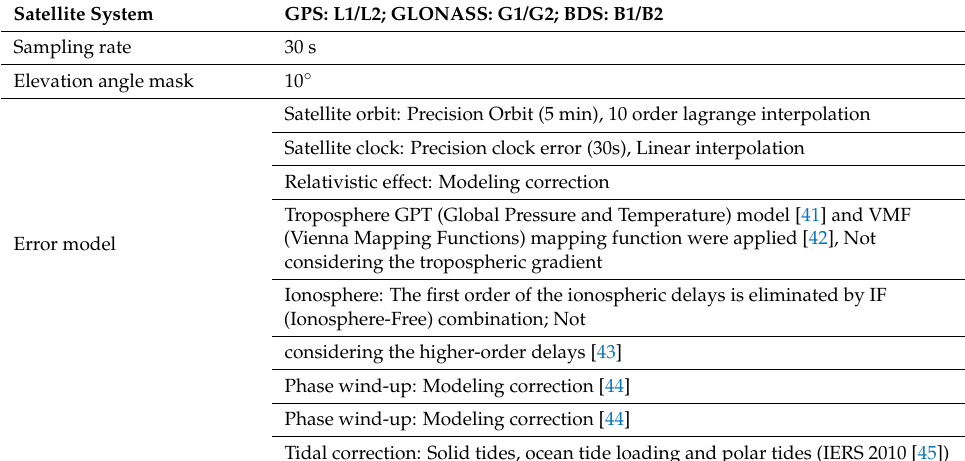
Table 2. Specific processing strategy for multi-GNSS observations based on the PPP